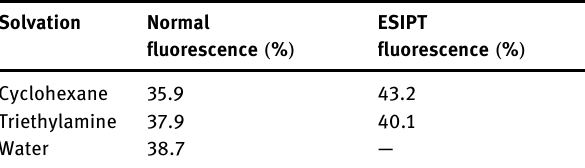
[ K* ( S )] 1 state LUMO 1